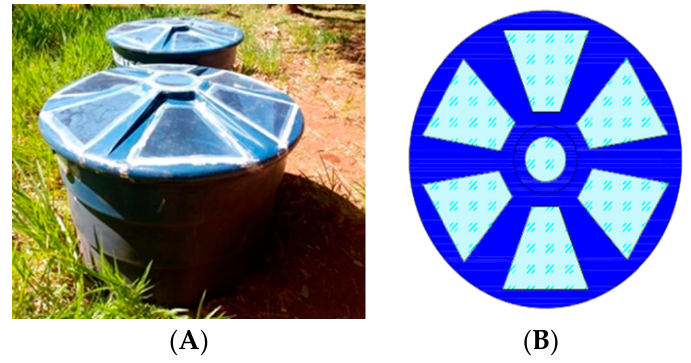
Figure 4. ( A ) Water tanks; ( B ) tank cover